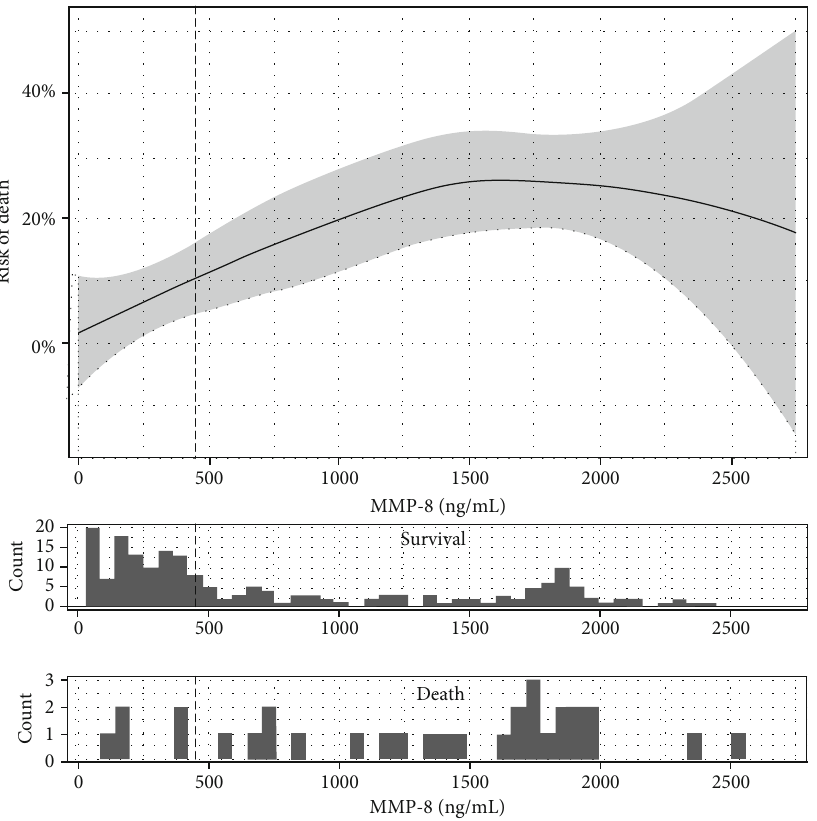
Figure 2: The risk of death estimated for di ff erent concentrations of MMP-8 using local regression. The vertical dashed line represents the median MMP-8 concentration, while the area shaded in grey shows the 95% con fi dence